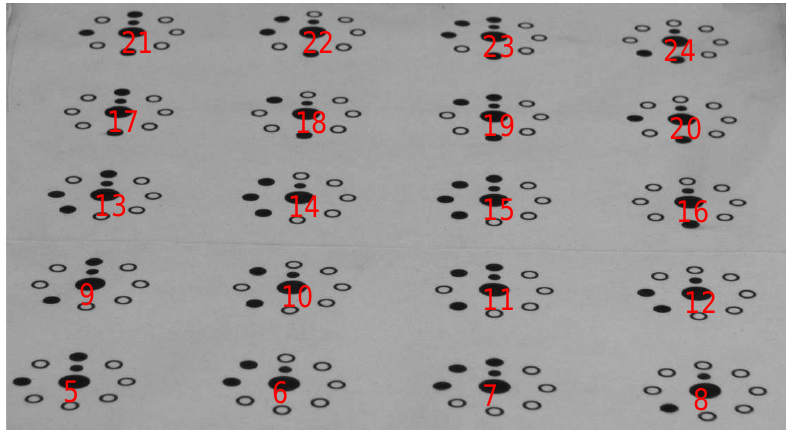
Figure 1. Solution model for obtaining the attitude angles for UAV landing.